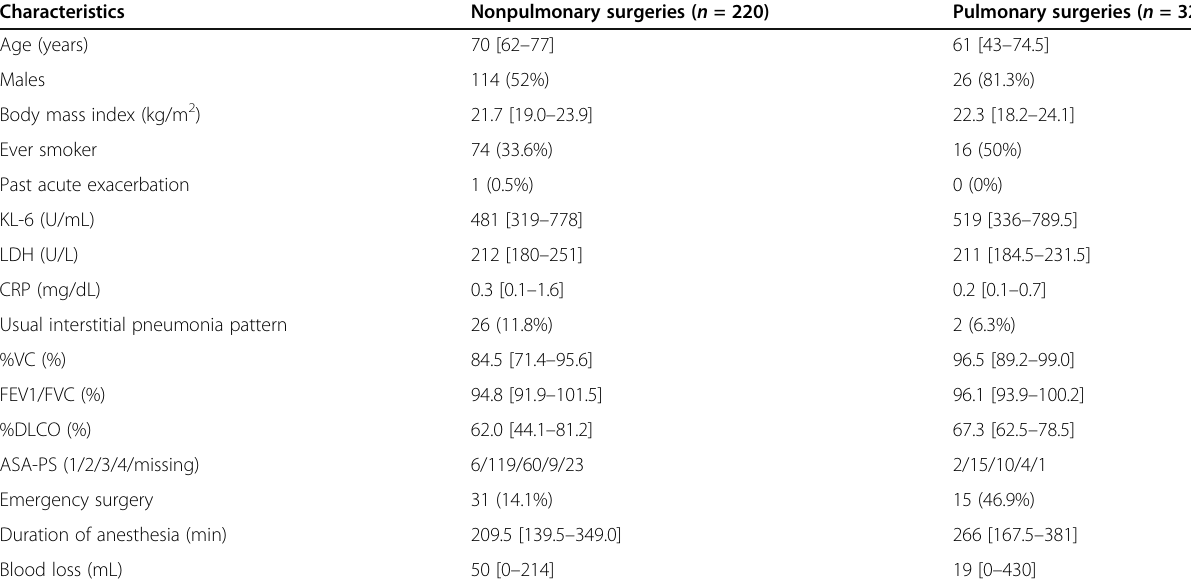
Table 1 Characteristics and operative variables of patients included in this study who underwent nonpulmonary and pulmonary